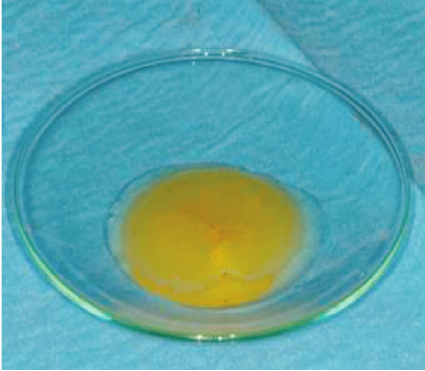
Figure 7: Membrane of a mixture of fi brin and poor plasma created.